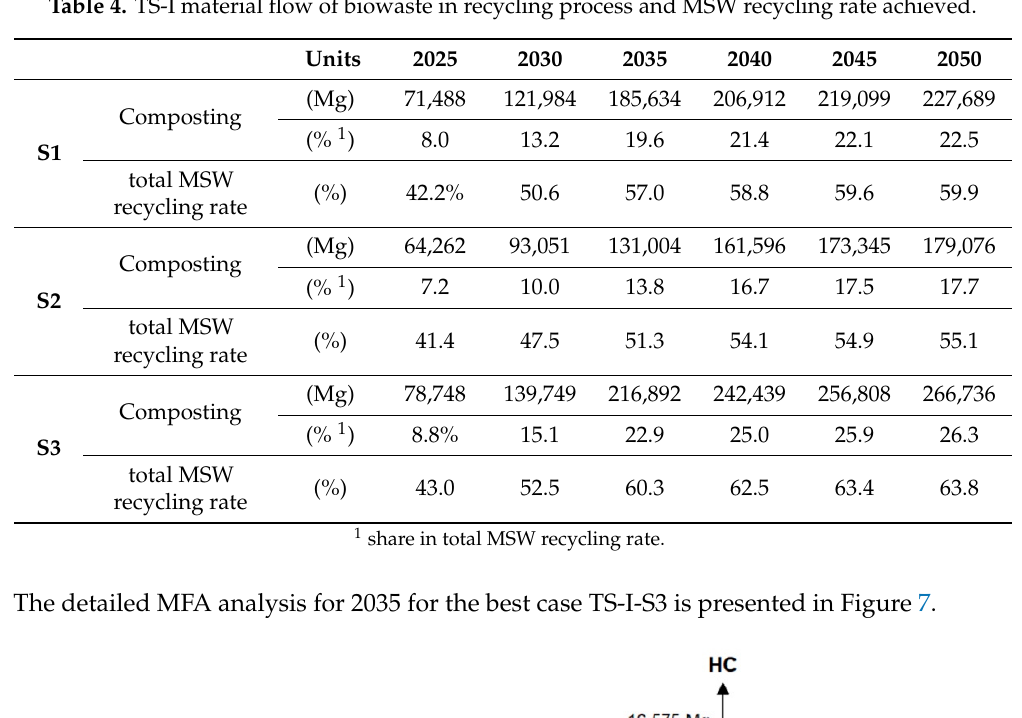
Table 4. TS-I material flow of biowaste in recycling process and MSW recycling rate achieved.